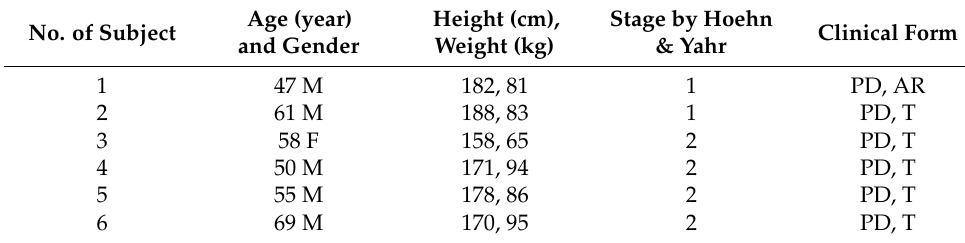
Table 1. The anthropometric and clinical data of the subjects with PD. No. of